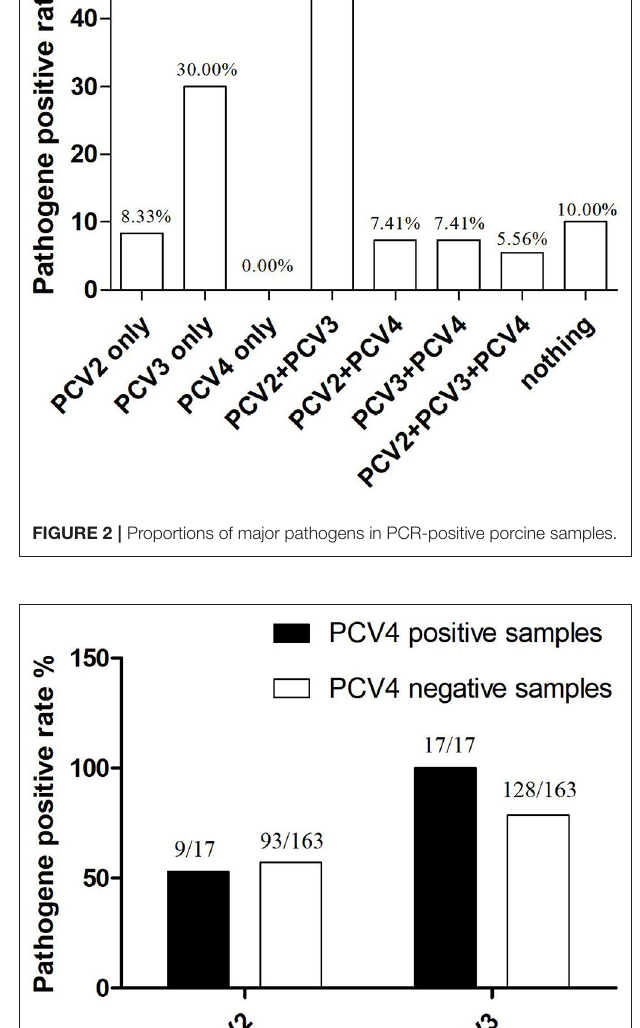
TABLE 2 | The positivity rate of PCV2, PCV3, and PCV4 in central Shanxi Province. City